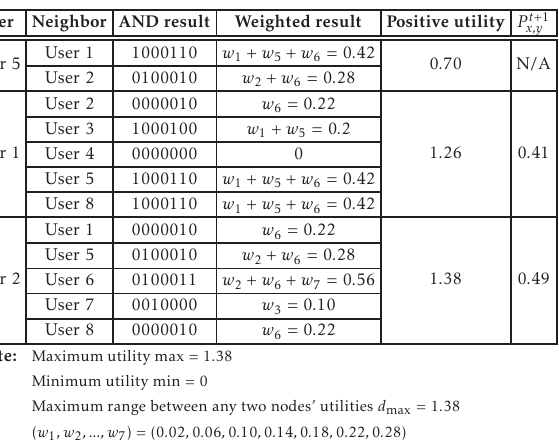
Table 1. The Process of Calculating Payoff Value and Choosing Mimic Object from the Candidate